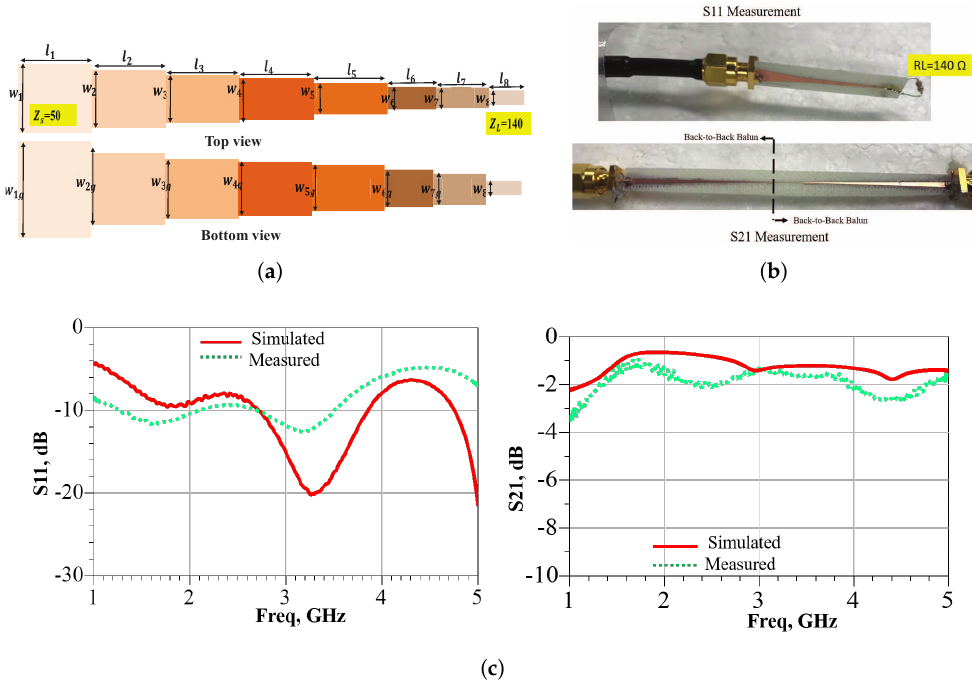
Figure 1. Fabricated balun layout and the measurement set-up for the performance characterization. ( a ) Photograph of the top and bottom view of the Balun layout; ( b ) Measurement set-up for S 11 and S 21 ; ( c ) Comparison between the measured and simulated